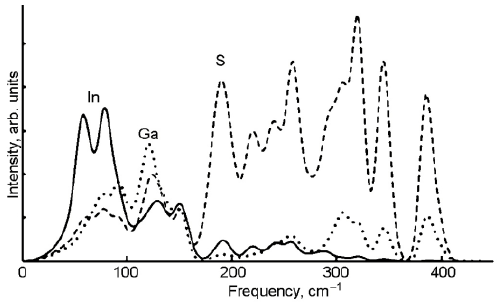
Figure 11. The atom projected phonon DOS of GaInS 3.